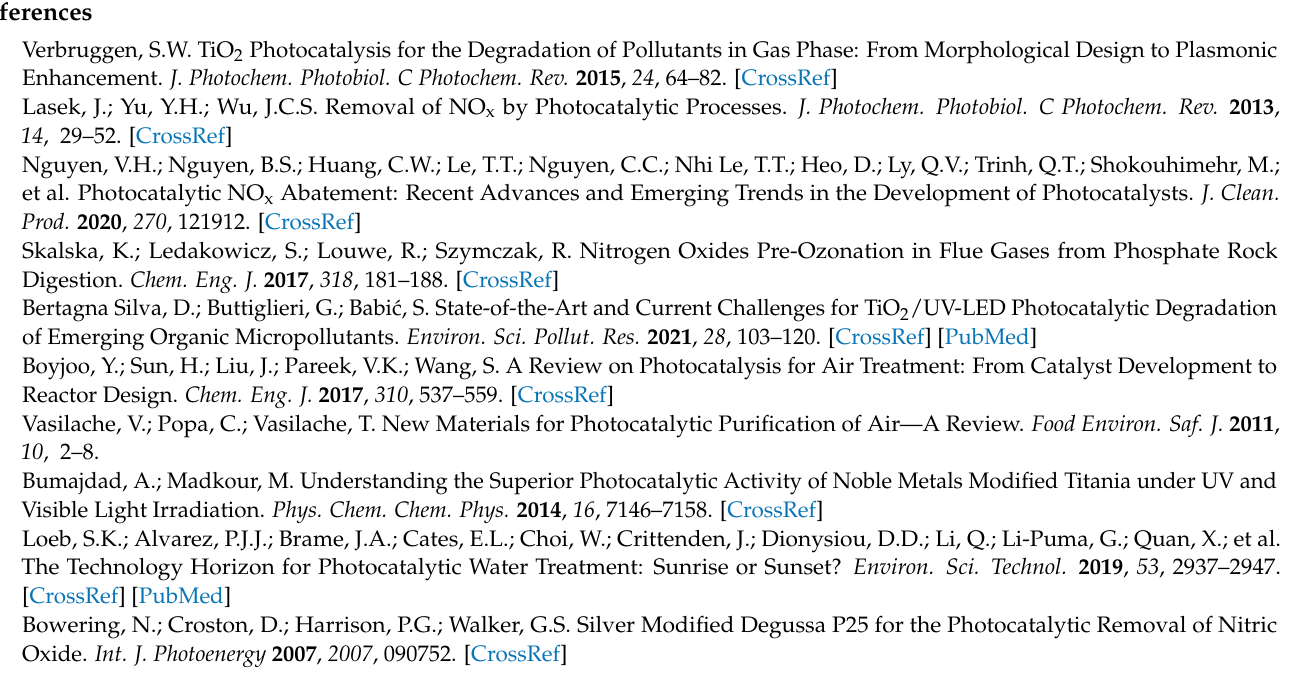
Figure S2: EDS components analysis for Au0.5 photocatalyst, Figure S3: NO conversions into NO 2 profile (a) SG, (b) Ag0.1 (c) Au0.1, Figure S4: HATR/FTIR spectra obtained for photocatalyst film before and after photocatalytic reaction; Table S1: Photocatalysts name, precursor used and its concentration together with PCs colors; Table S2: Basic characteristics of studied